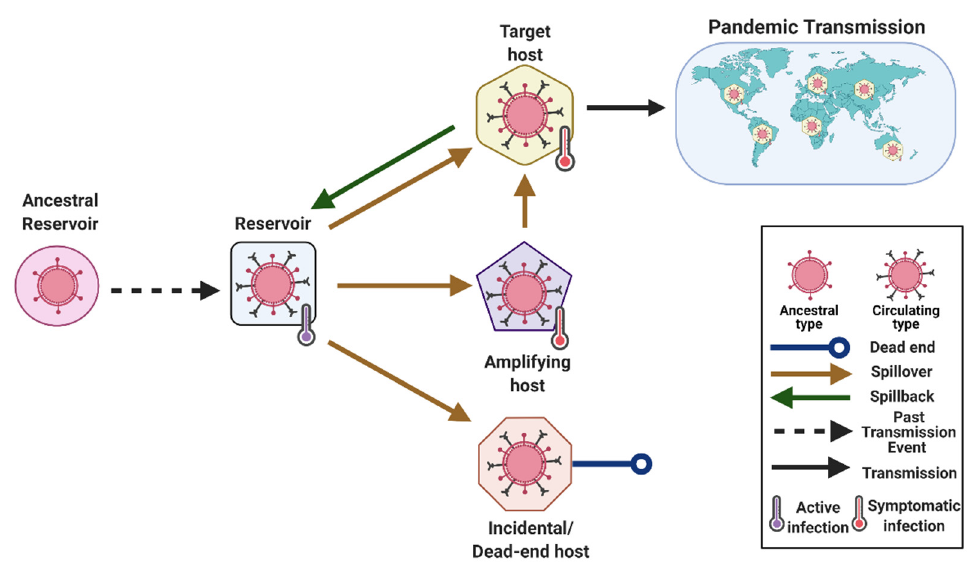
Figure 1. Schematic diagram illustrating some of the key terms defined in this paper. Each colored shape represents a different, generic “species” that serves as a particular type of host for a generic microbe. Arrows indicate different types of transmission, such as spillover and spillback.